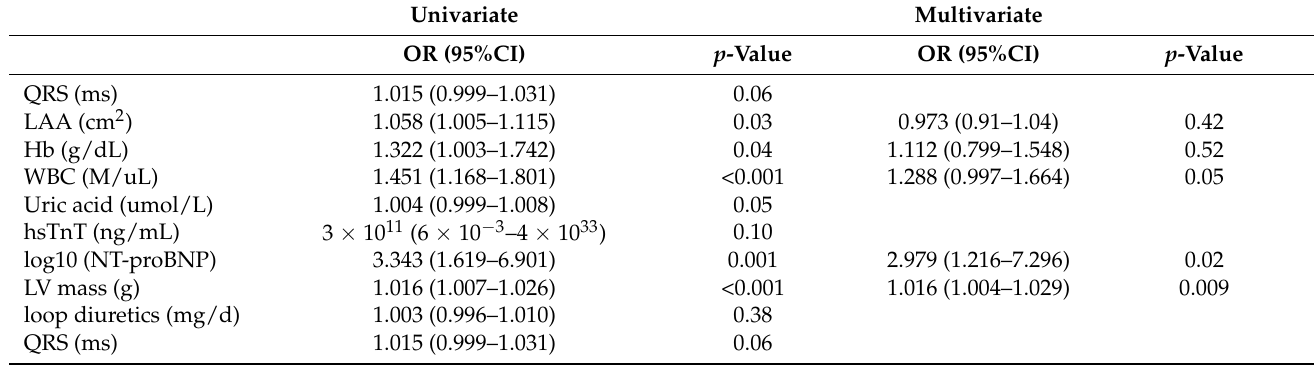
Table 3. Uni- and multivariate logistic regression models for the prediction of LGE presence.